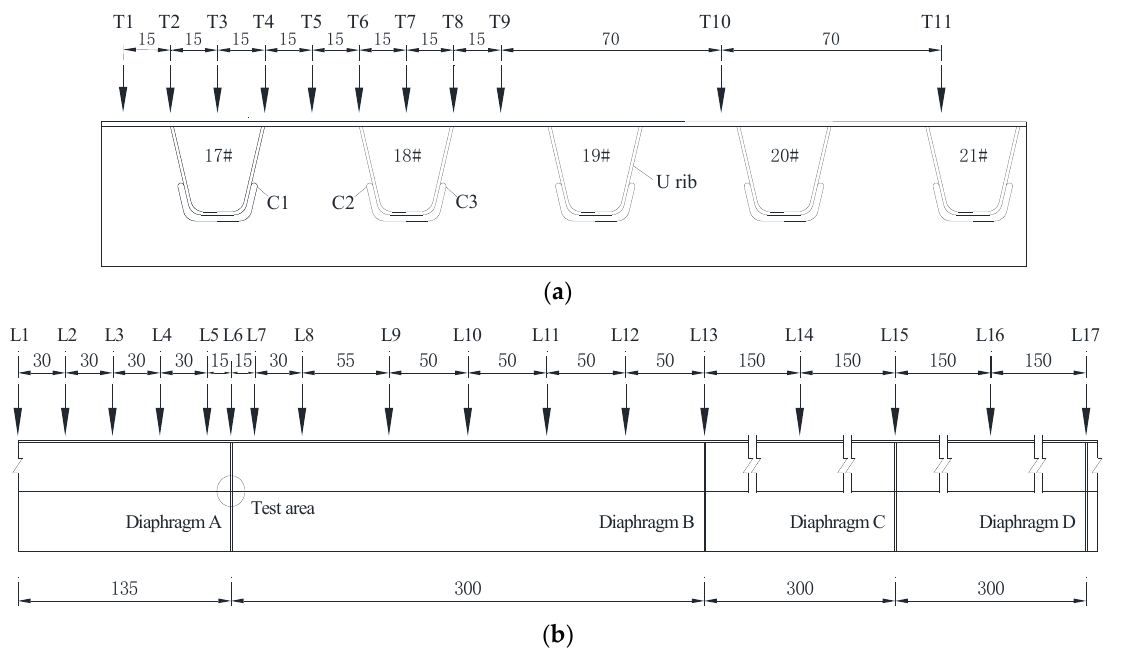
Figure 9. Load programs (unit: cm): ( a ) Lateral loading program, ( b ) longitudinal loading program.